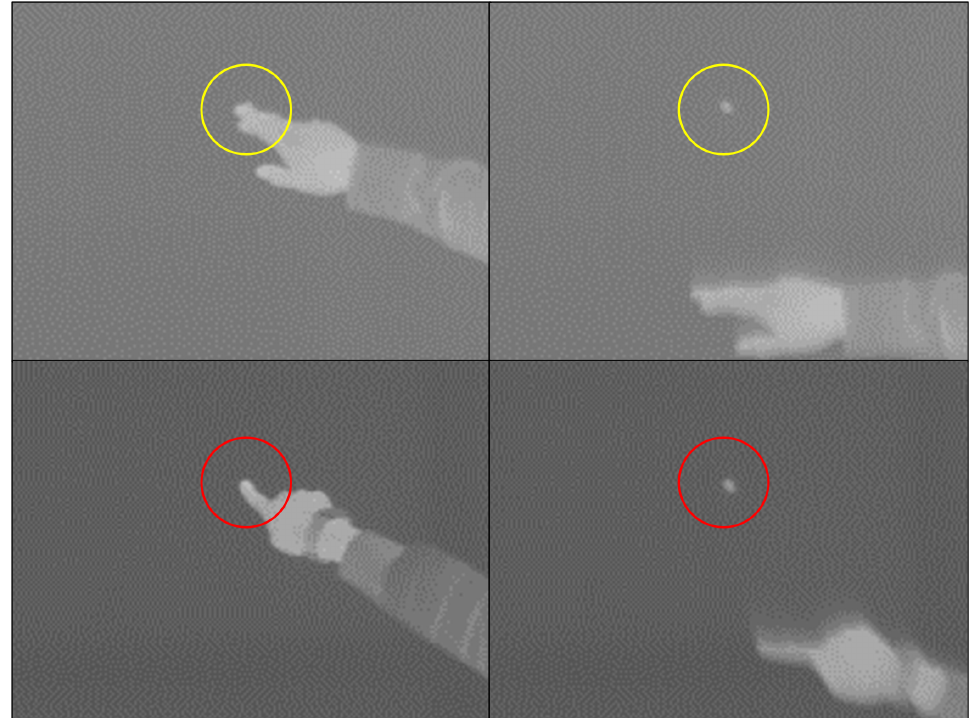
Figure 1. Comparison of fingertip touch conduction hot spot. (Material: canvas paper for oil painting) Top : upper part of the finger 33.27 degrees, hot point 29.94 degrees, surface 24.72 degrees. (Yellow circle: touch area) Bottom : upper part of the finger 32.06 degrees, hot point 27.81 degrees, surface 21.23 degrees. (Red circle: touch